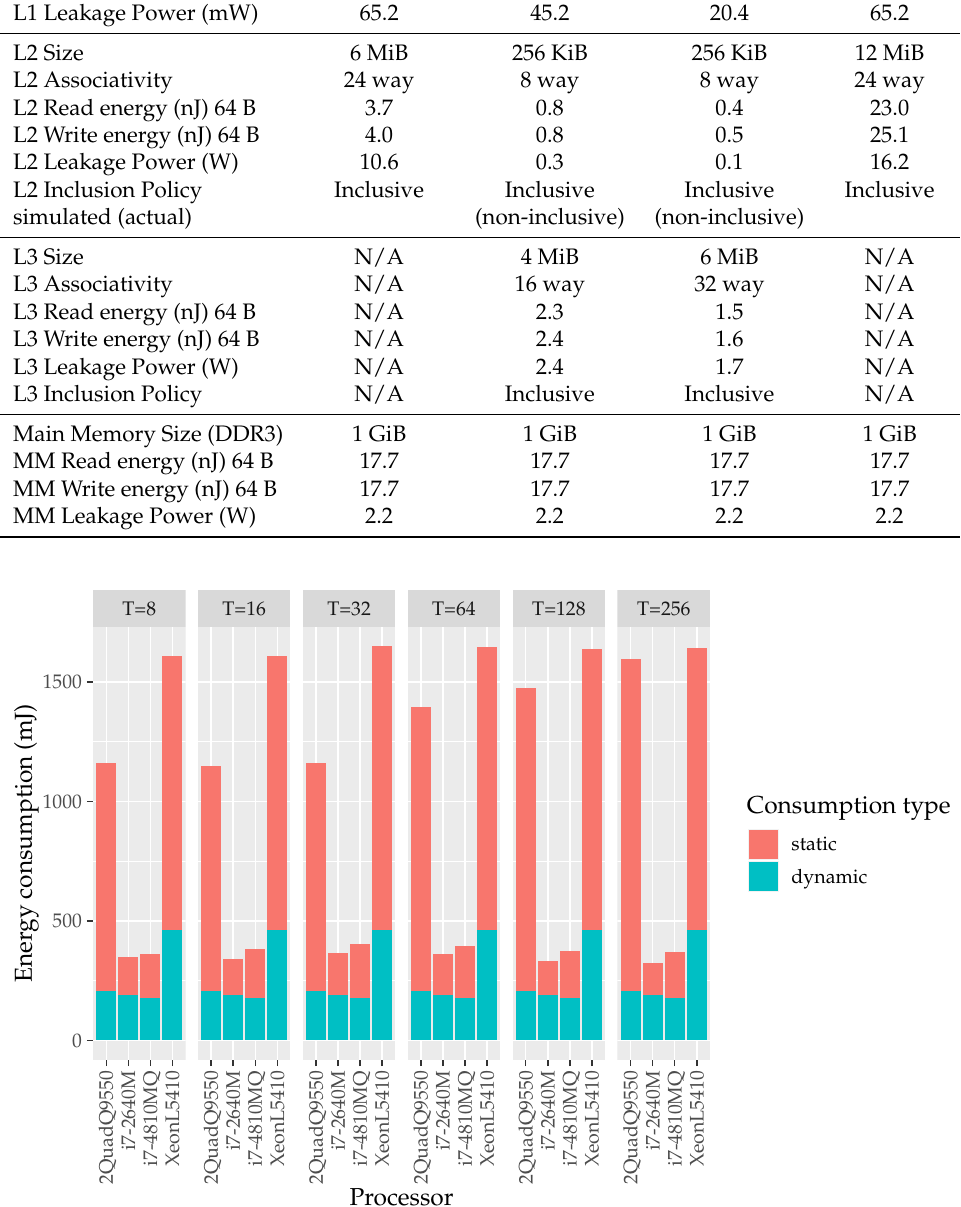
Figure 13. Energy consumed by the memory hierarchy of the experimental systems for different tile sizes.